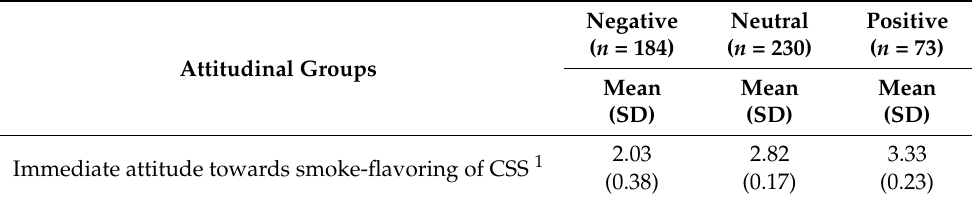
Table 3. Immediate attitude 1 grouping towards smoke-flavoring of CSS with mean global scores and standard deviation (SD) ( n = 487).